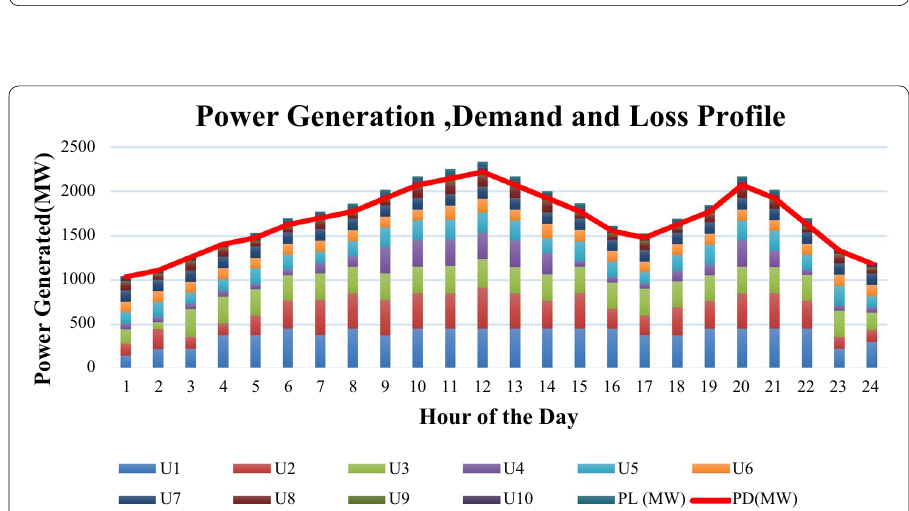
Fig. 4 Power generation, power demand and loss profile over 24-h period in a day for test case